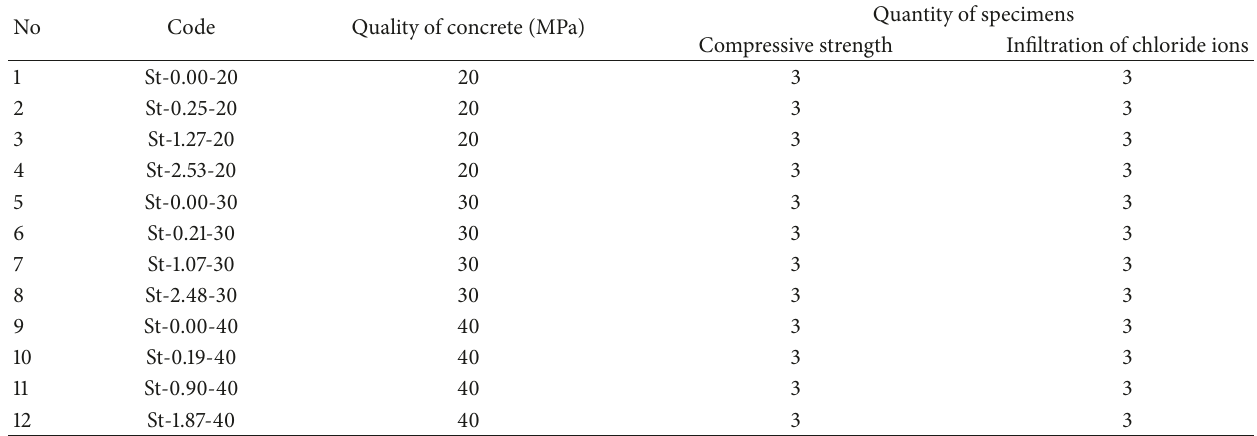
Table 2: The quantity of